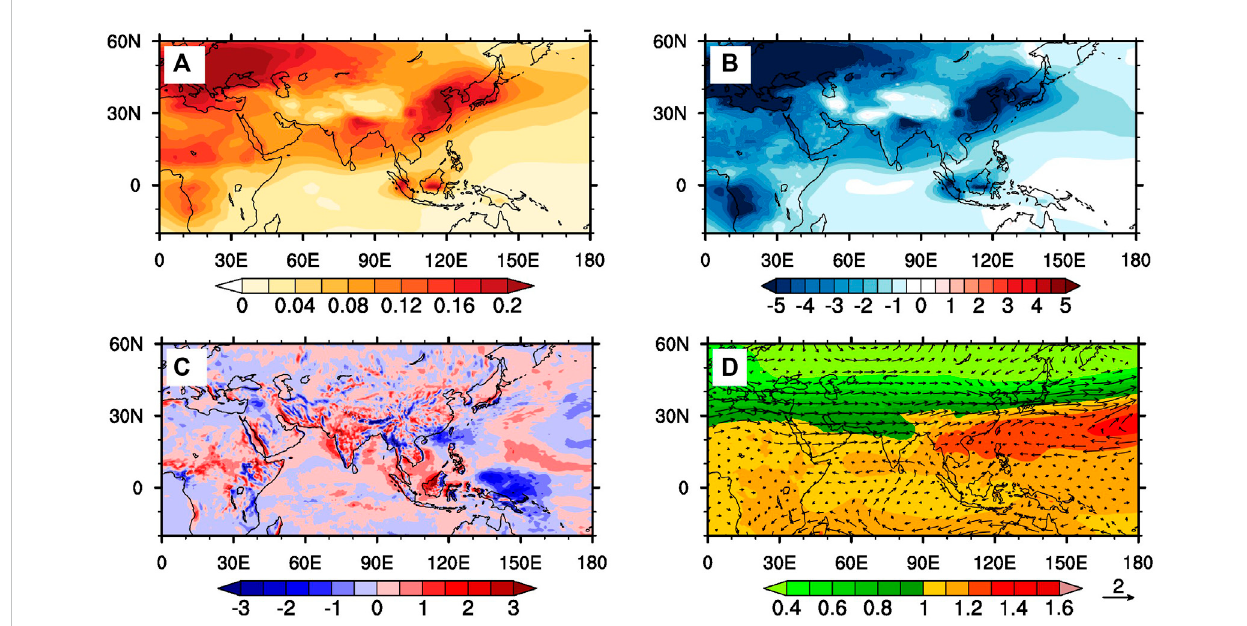
FIGURE 6 Difference (HIST-HISTNAT)mapsoftheJJAStime-mean fi eldsfortheperiod(1951 – 2005): (A) Aerosolopticaldepth(AOD) (B) Netradiativeforcing atthesurface(Wm -2 ) (C) 550 hPaverticalvelocity ⍵ (x100 Pa s -1 ) (D) Verticallyaveragedtemperature( o C)andwinds(vector,ms − 1 )fromthemid-to-upper troposphere (600 – 150